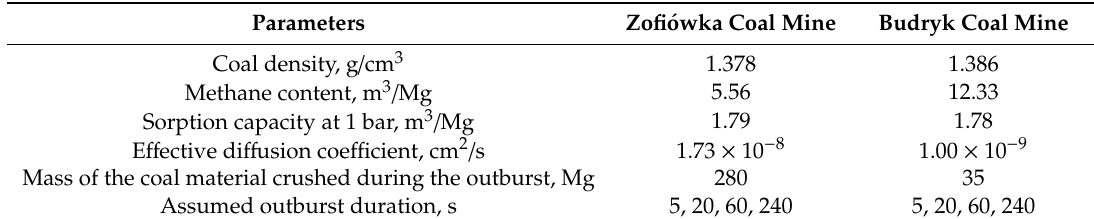
Mass of the coal material crushed during the outburst,